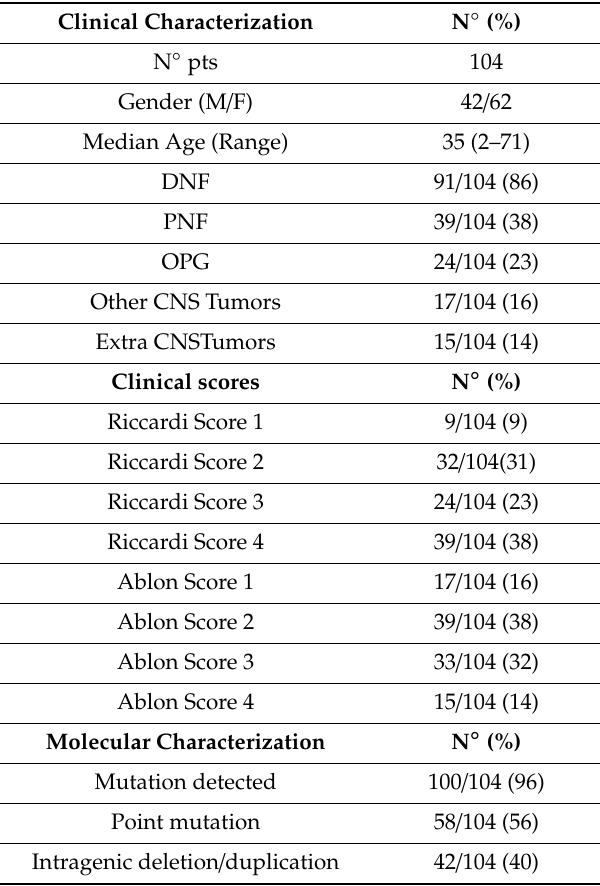
Table 1. Clinical and molecular features of the analyzed.